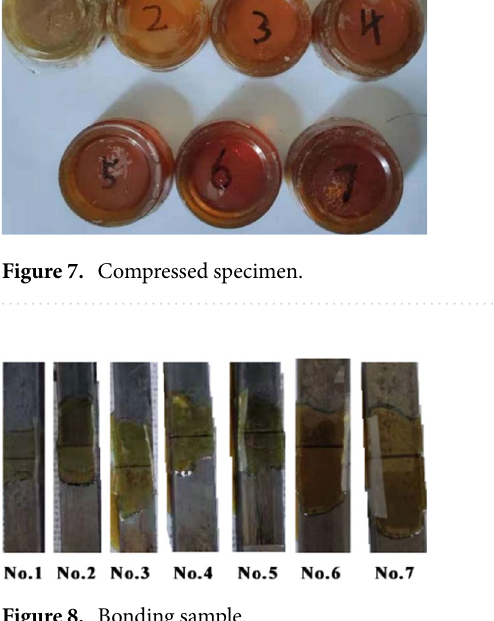
Figure 8. Bonding